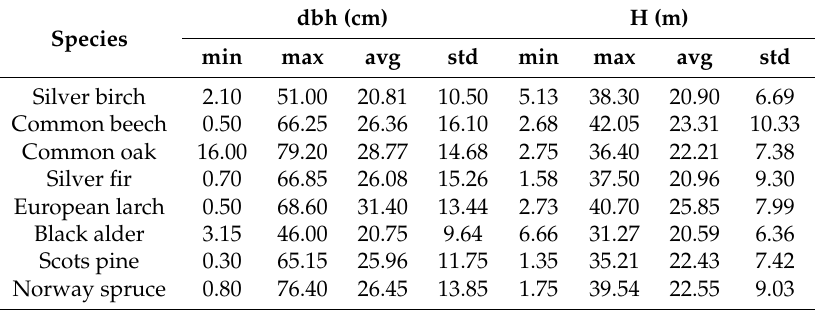
Table 2. Summary statistics of diameter at breast height (dbh) and total tree height (H) for different tree